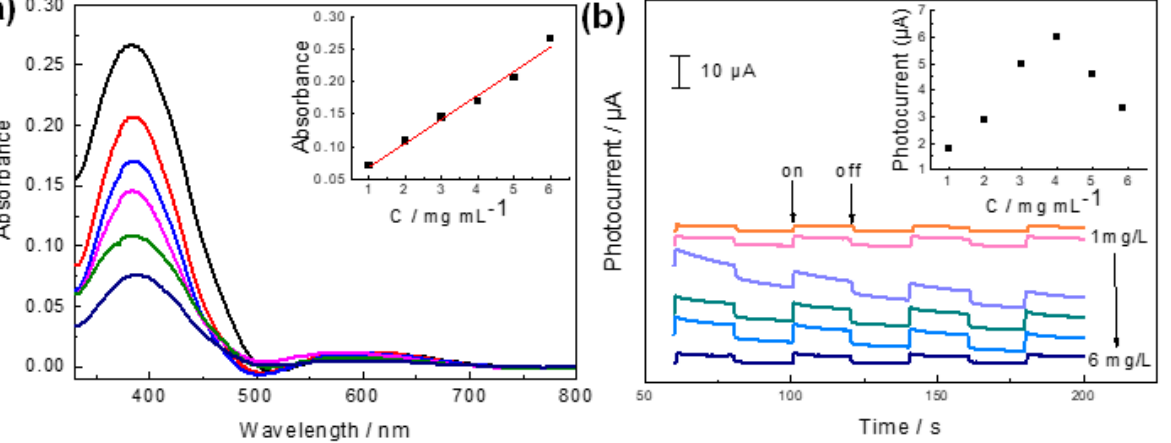
Figure 6. ( a ) The absorption spectra of the films prepared from [Re(CO) 3 Cl(L)] DCM solutions of varying concentrations of 1, 2, 3, 4, 5 and 6 mg mL − 1 (from bottom to top). Inset: A plot of the absorbance of the films at 387 nm vs. concentrations of the Re complex in the drop-casting solutions. ( b ) Photocurrent responses of the films biased at − 0.4 V vs. SCE under 100 mW/cm 2 white light irradiation. Inset: A plot of the photocurrent vs. concentrations of the drop-casting